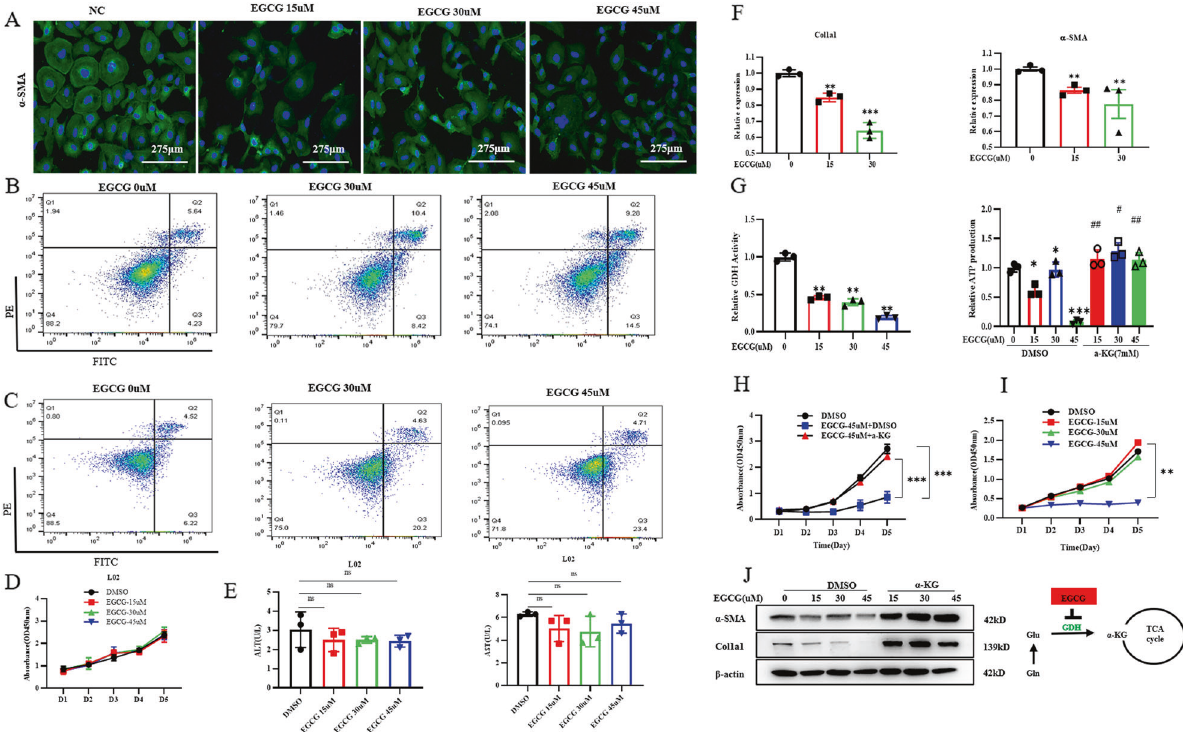
Fig. 1 Glutaminolysis is critical for energy production and anabolism of myo fi broblastic HSCs. LX-2 cells were grown in complete medium treated with glutaminolysis inhibitors or vehicle (0.1% DMSO) for 1 – 5 days. A Immuno fl uorescence analysis of α ‐ SMA expression (scale bars = 275 μ m). B Effects of EGCG on the apoptosis of LX2 cells. C Effects of EGCG on the apoptosis of L02 cells. D Cell growth of L02 cells was determined by CCK-8 assay. E ALT and AST levels in L02 cells supernatant. F Quantitative real ‐ time PCR analysis of the gene expression of α ‐ SMA and Col1a1. G Glutamate dehydrogenase (GDH) enzyme activity and ATP production. H , I Cell growth of LX2 cells was determined by CCK-8 assay. J Western blot analysis of the protein expression of α ‐ SMA and Col1a1. The data are reported as the mean ± SD. * P < 0.05, ** P < 0.01, and *** P < 0.001 versus the respective control. # P < 0.05, ## P < 0.01, and ### P < 0.001 versus the respective DMSO